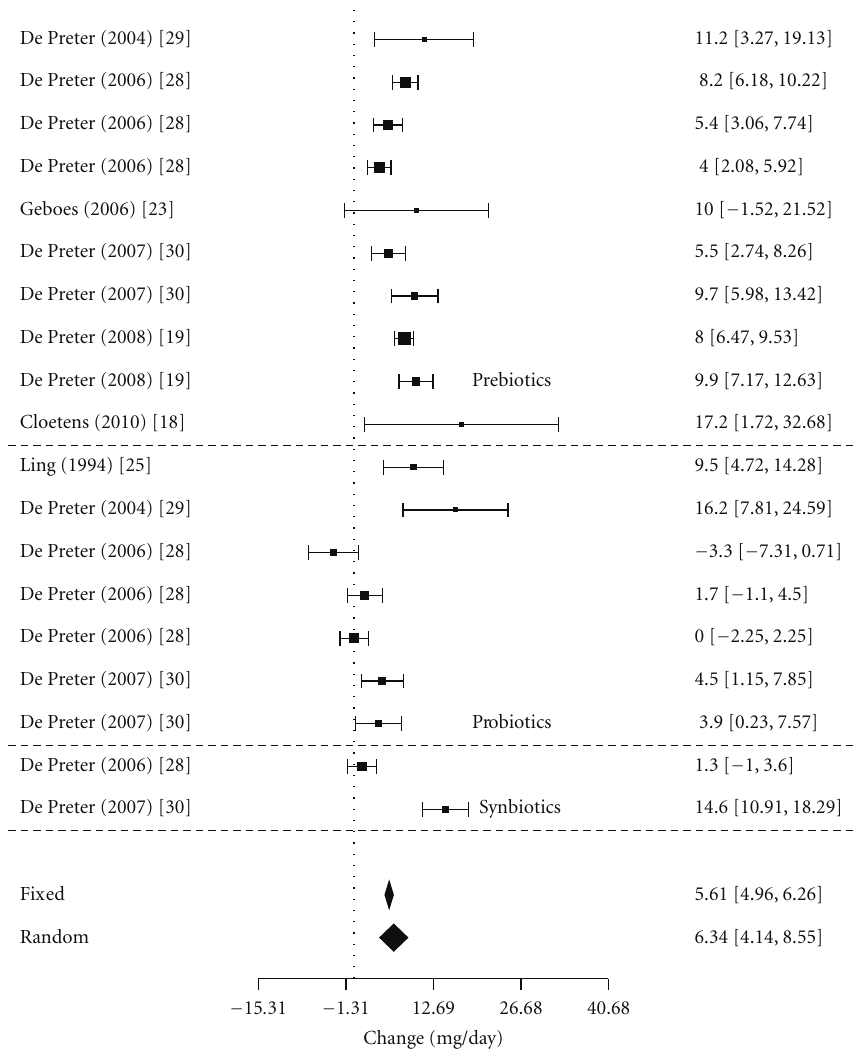
Figure 3: Meta-analysis for pre-, pro-, and synbiotic therapy on urinary PCS in the healthy population.